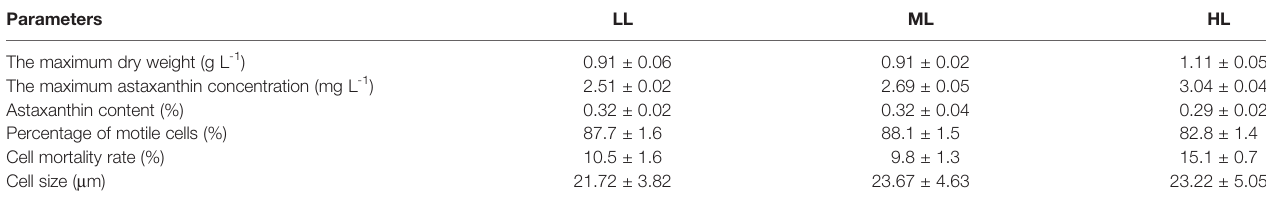
TABLE 1 | The maximum dry weight and astaxanthin concentration, percentage of motile cells, cell mortality rate, and cell size in the LL, ML, and HL group. Parameters LL ML HL The maximum dry weight (g L -1